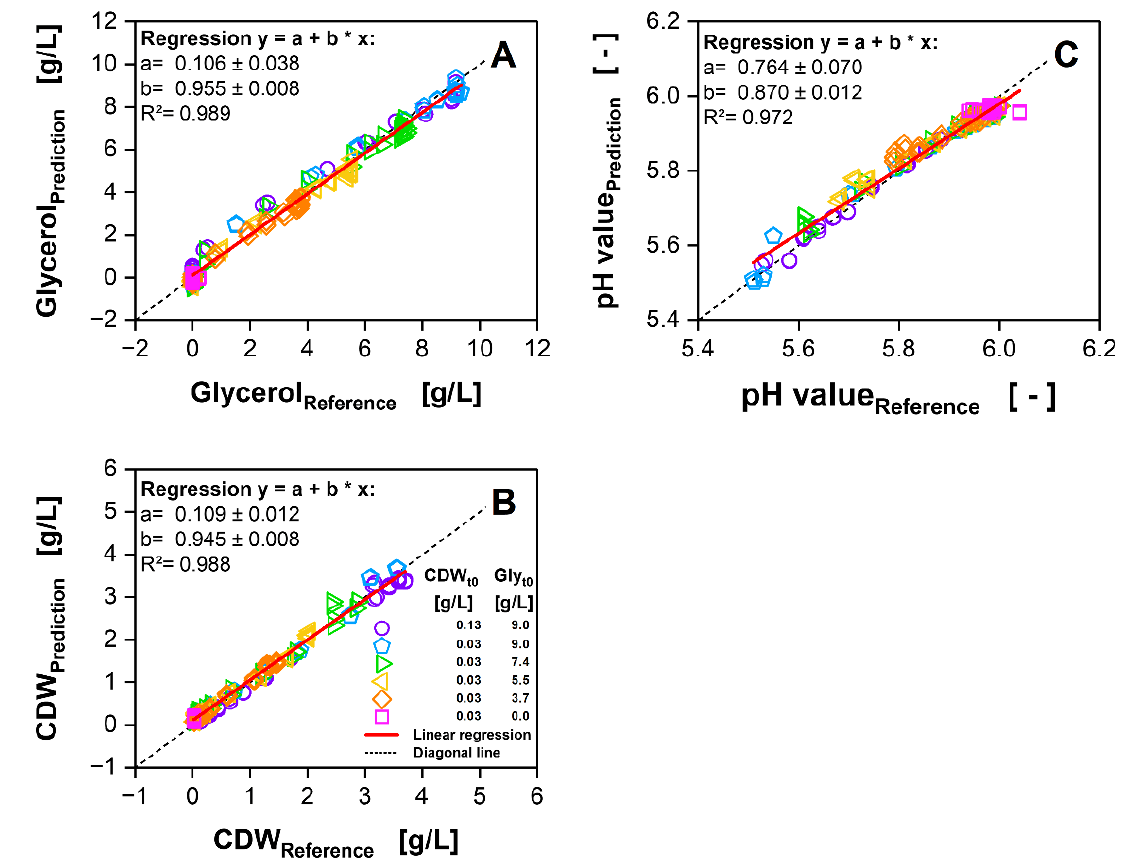
Figure 7. Parity plots for the duplicate-based PLS prediction of offline parameters ( A ) glycerol, ( B ) cell dry weight (CDW) and ( C ) pH value, using two latent variables on 2D spectra of duplicates of H. polymorpha RB11 pC9- FMD (P FMD -GFP) cultivations in SYN6 medium at six different initial cell dry weights (CDW t0 ) and glycerol concentrations (Gly t0 ). Only data points with corresponding offline sampling data, indicated by a hollow symbol in Figure 6, are plotted. Red line shows resulting linear correlation between predicted values and reference offline values.